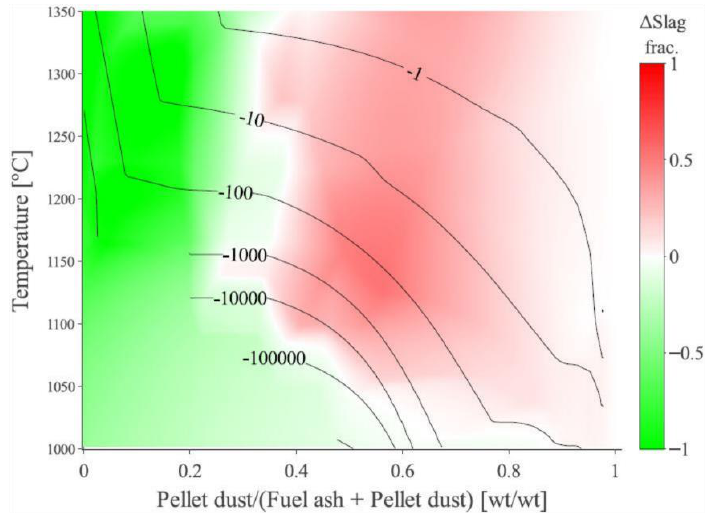
Figure 4. Plot of Δ(slag frac.) comparing the predicted melt formation (when mixed with pellet dust) for coal vs. raw stem wood. Δ(slag frac.) = (slag frac.) stem wood − (slag frac.) coal . Contours indicate the difference in estimated viscosities (stem wood vs. coal). Energies 2020 , 13 , x FOR PEER REVIEW